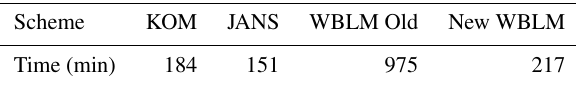
Table 1. The calculation time of KOM, JANS, the previous WBLM of Du et al. (2017) (WBM Old), and the new WBLM during the idealized fetch-limited study. Scheme KOM JANS WBLM Old New WBLM 151